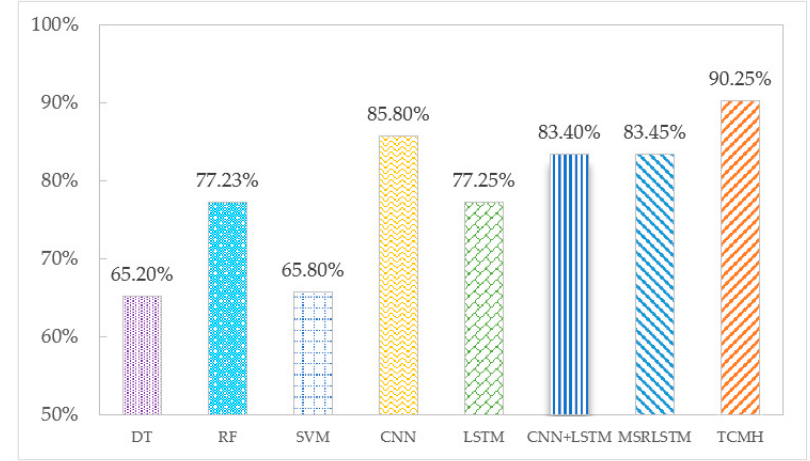
Figure 5. Accuracy of each algorithm on the SHL dataset.